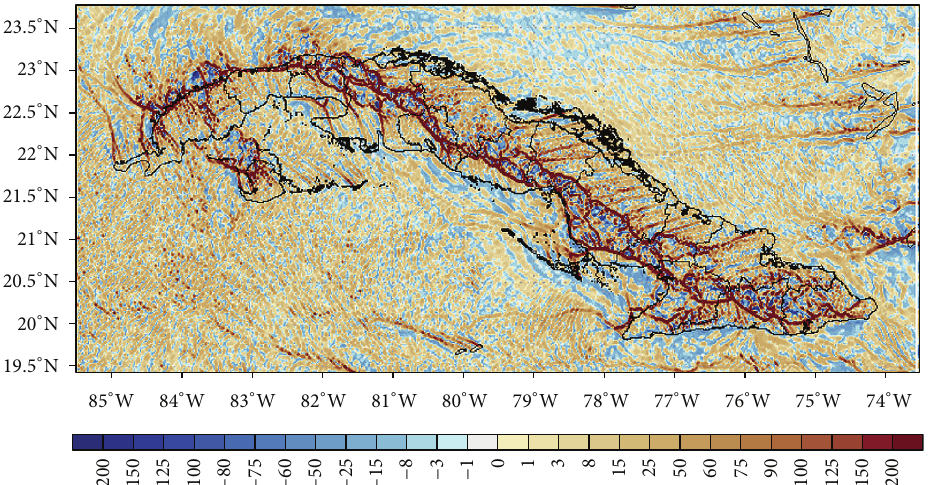
Figure 4: WRF simulation of surface moisture convergence (1/s) valid at 1900UTC on 1 May 2012. Positive values are moisture convergence.